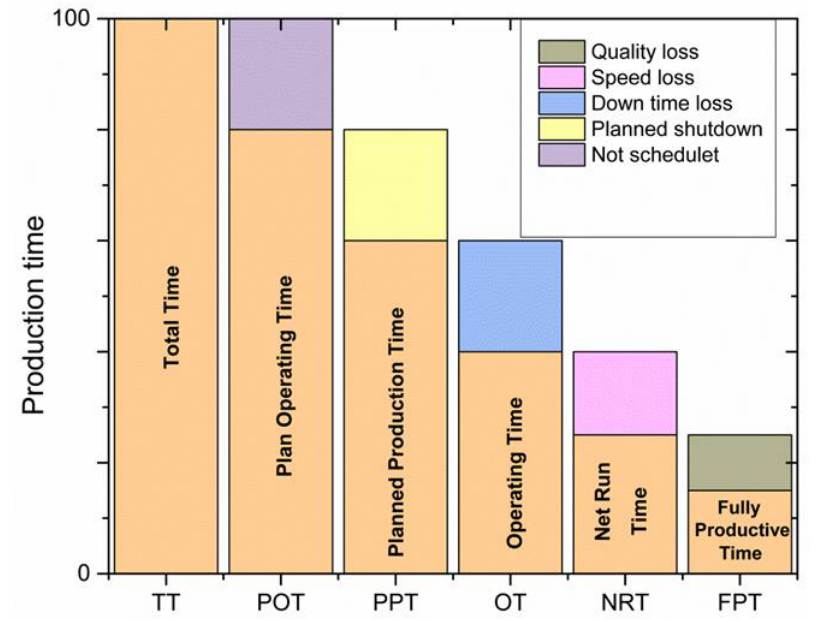
Figure 3. The overall equipment effectiveness time